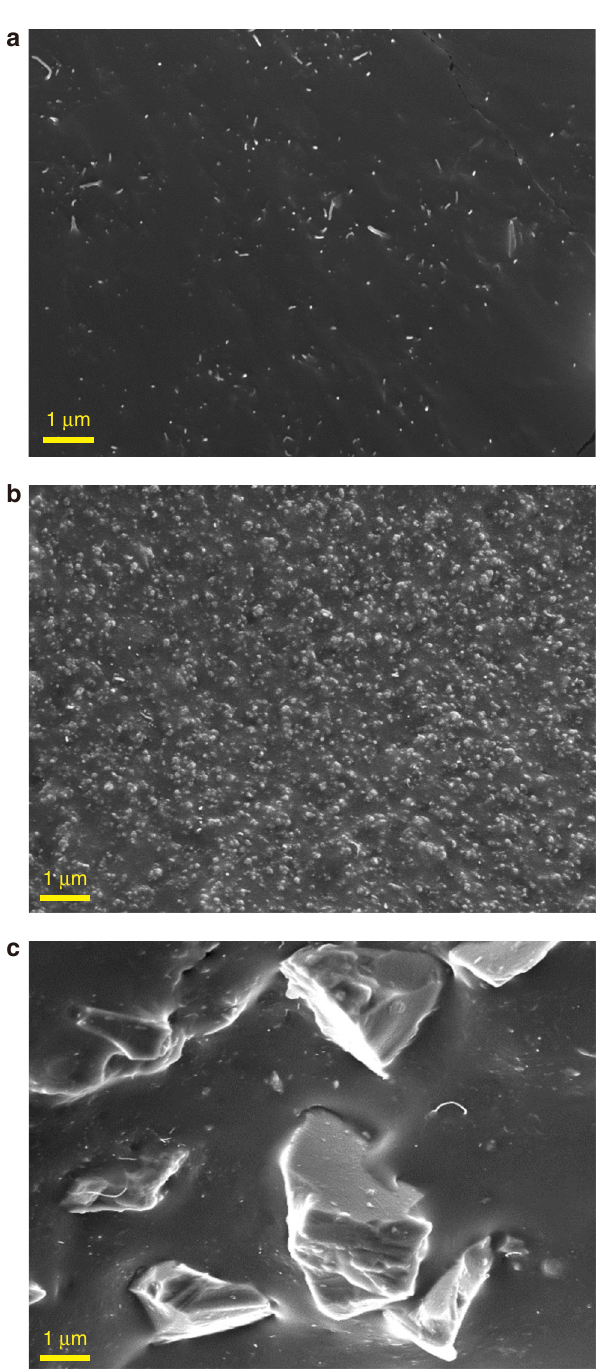
Fig. 2 SEM images of CNT composites. a CNT composite without silica fi llers. b Nano-silica fi llers with diameter of 20 nm. c Micro-silica fi llers with diameter of 3 – 4 μ